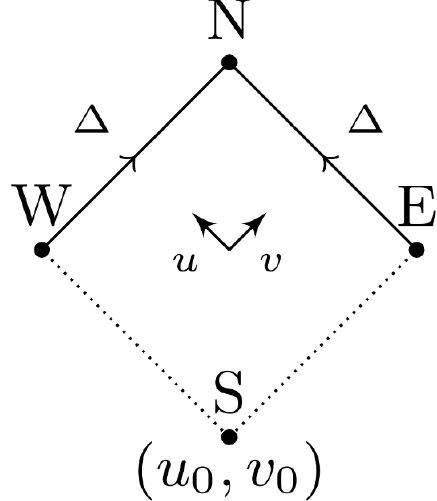
Figure 1 . Crank-Nicolson method to obtain the data at N from the data at E and W for the Dirac